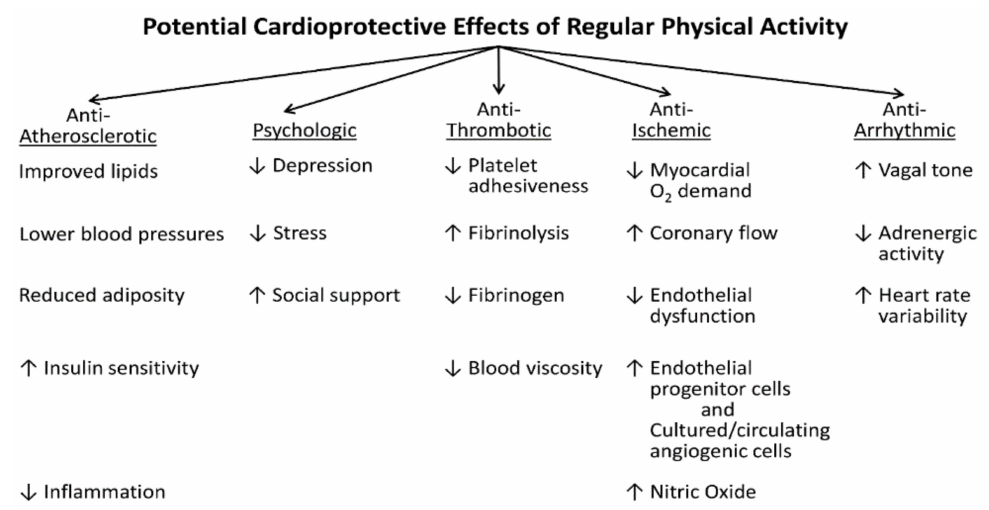
Figure 6. Multiple mechanisms by which moderate-to-vigorous physical activity may reduce the risk of initial and recurrent cardiovascular events. ↑ , increased; ↓ , decreased; O 2 ,